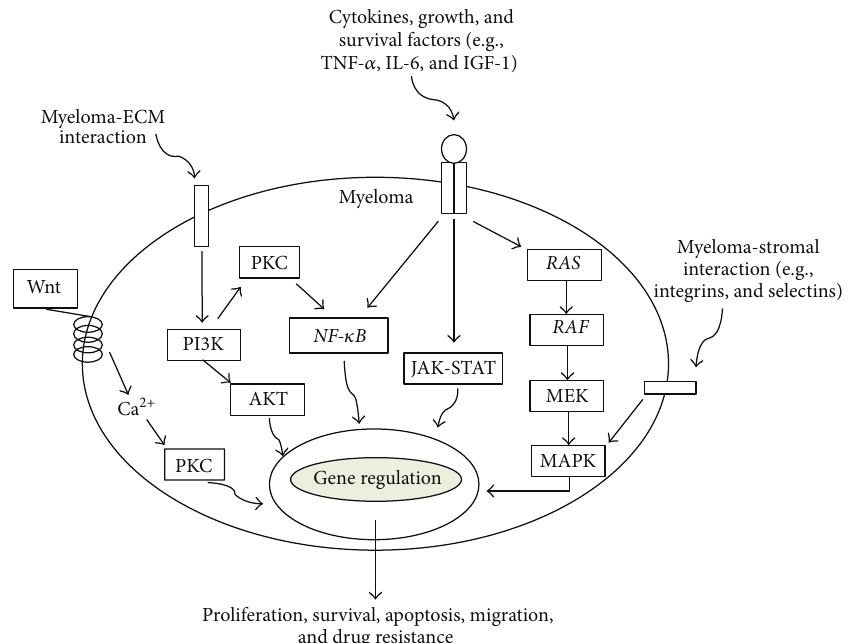
Figure 4: Signalling pathways involved in myeloma pathogenesis . The various pathways involved in myeloma pathogenesis may be stimulated viaexogenousfactors,suchasWntproteins,myeloma-stromalinteractions,cytokines,growthandsurvivalfactors,andmyeloma-extracellular matrix (ECM) interactions, or the pathways may be aberrantly activated endogenously through genetic abnormalities such as activating mutations in RAS , RAF , and NF- 𝜅 B